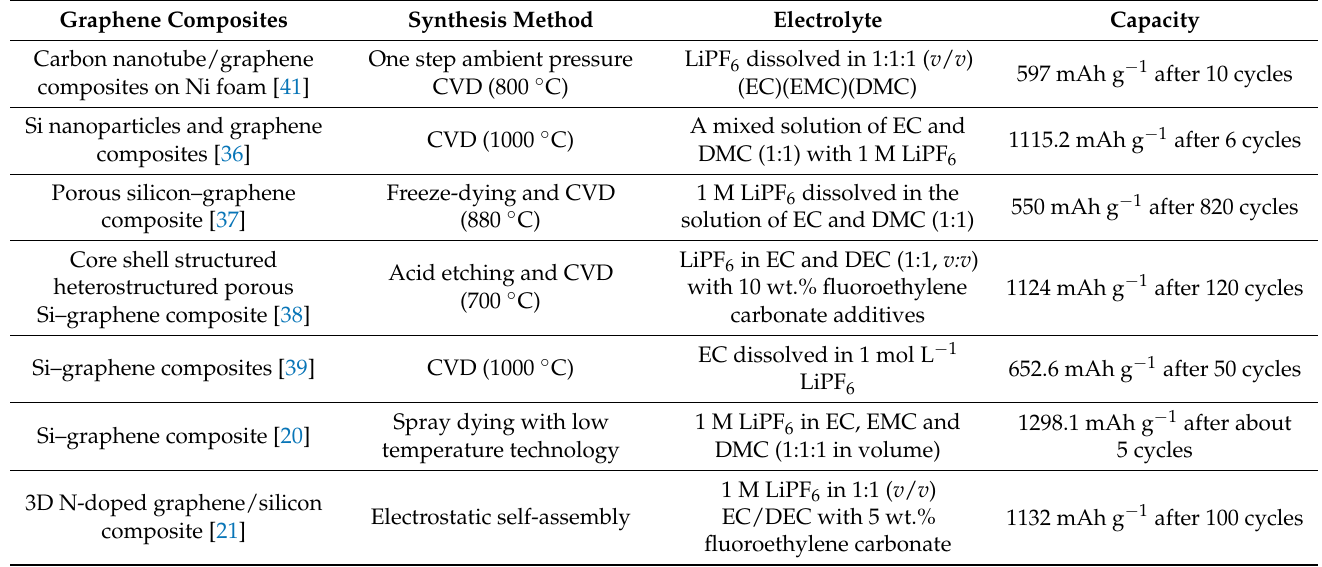
Table 1. Growth methods of graphene-based composites with their capacity